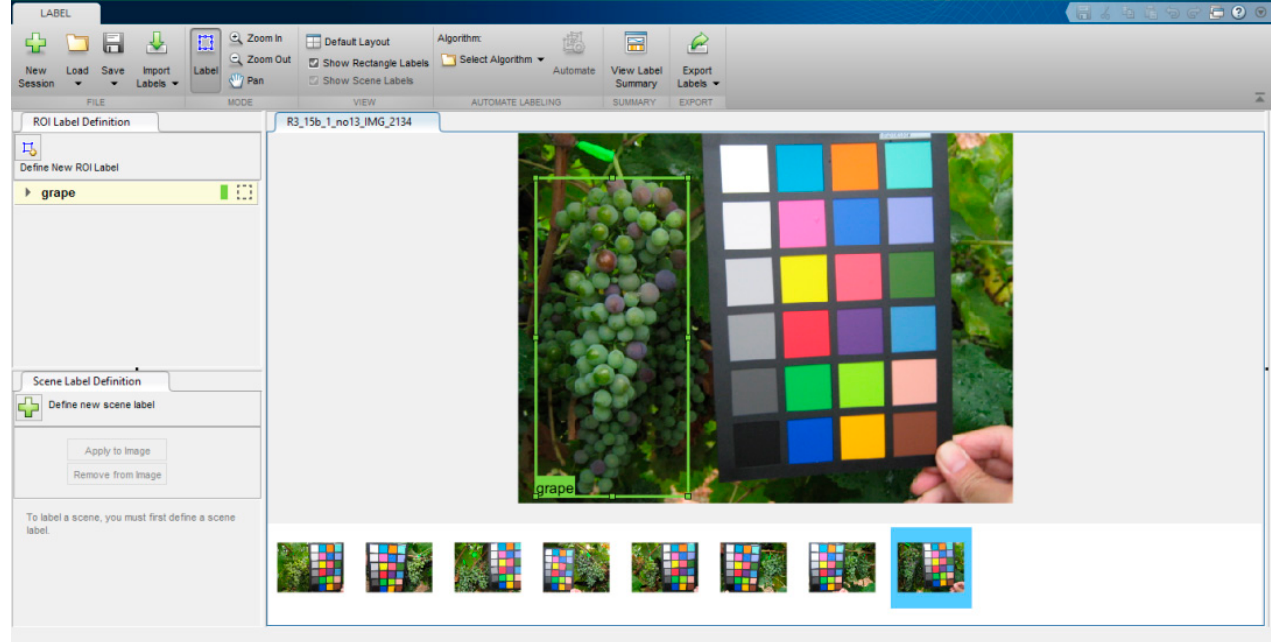
Figure 2. MATLAB Image Labeler used in the labeling process. For each image the smallest bounding box was hand drawn around every bunch of grapes.